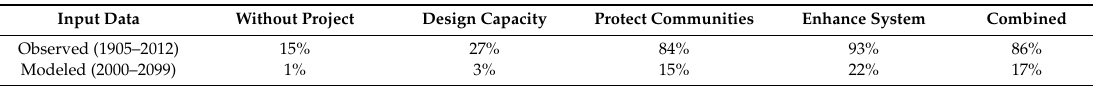
Figure 11. Posterior interval boxplots of: ( a ) Mean peak annual flow, µ , and ( b ) standard deviation, σ , of peak annual flow for observed streamflow data from 1905–2012 (orange box) and GCMs forced with future emissions scenarios (purple boxes) from 2000–2099. The whiskers signify the 95% posterior interval, with quartiles around the median value (black line) indicated with the boxes. Table 4. EAD robustness indicator, percent of posterior draws of flood frequency parameters that yield an EAD below the